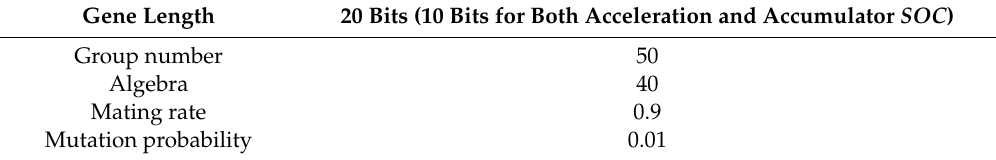
Table 1. Parameter settings of genetic algorithm